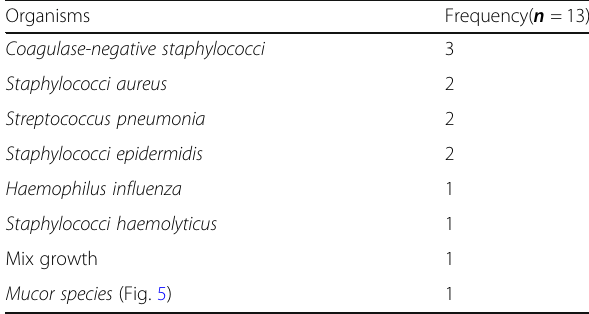
Table 3 Causative microorganism ’ s results